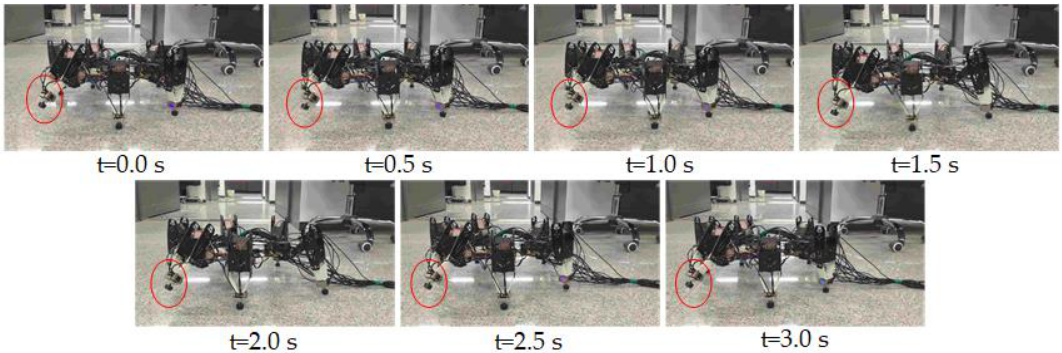
Figure 24. A set of snapshots of the walking experiment with leg 1 fault.